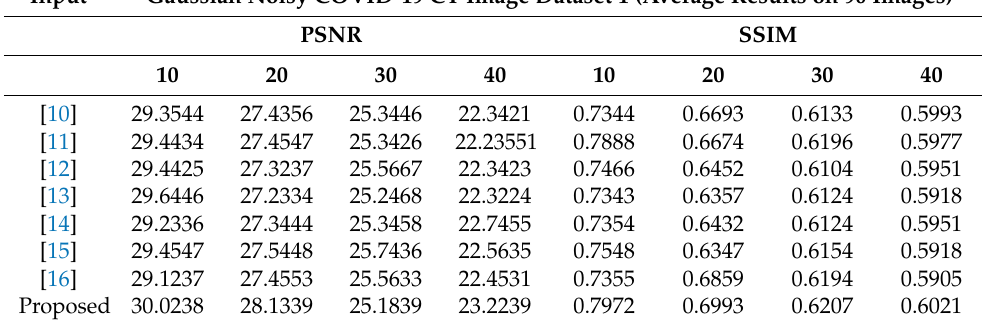
Table 2. PSNR and SSIM of noiseless CT